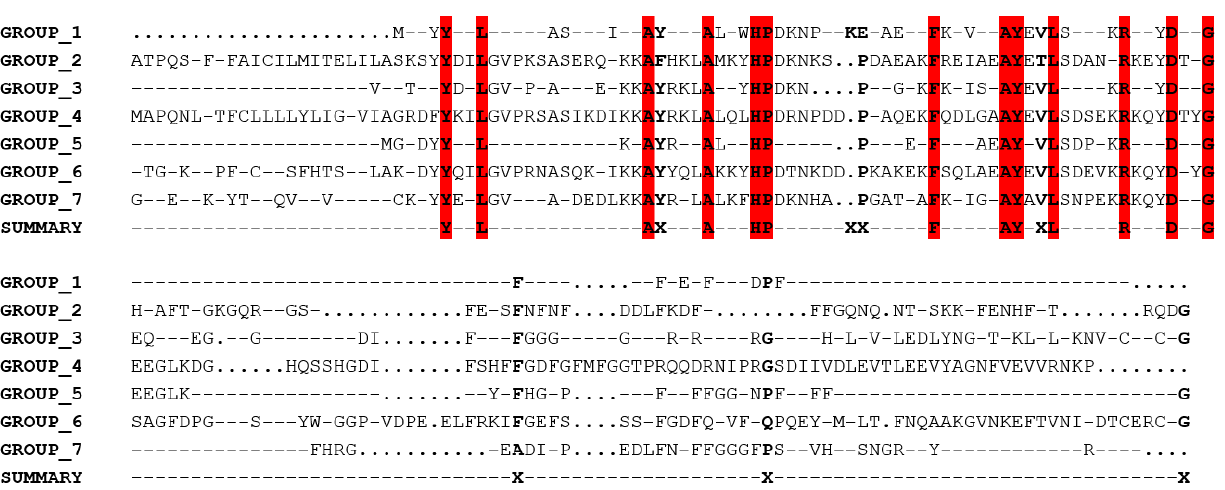
Figure 5. Evolutionary trace analysis of the heat shock protein 40 (HSP40) gene family in human, mouse and cattle (J domain region only). Every member of HSP40 gene family were partitioned into seven different groups based on the degree of conservation. All groups consisted of human, mouse and cattle sequences. Group 1 consists of DNAJB2, DNAJB3, DNAJB6, DNAJB7 and DNAJB8. Group 2 consist of only DNAJB9; Group 3 consists of DNAJA1, DNAJA2, and DNAJA4; Group 4 consists of DNAJB11; Group 5 consists of DNAJB1, DNAJB 4, DNAJB 5 and DNAJB 13; Group 6 consist only DNAJA3 while Group 7 consist of DNAJB12 and DNAJB14. Conserved residues were colored red and they were all localized in the J domain while class specific residues were denoted by the sign “X”. The symbol “….” Represents the presence of invariant residue in each group while the symbol “----” represents the absence of a residue at that position.